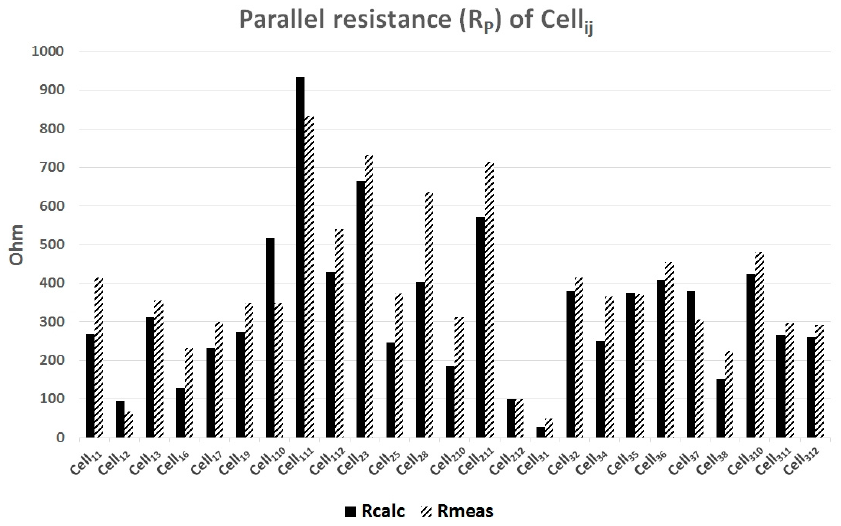
Figure 20. Manually measured resistances of some cells (Rmeas) vs. resistances calculated from the slopes in Figure 18 (Rcalc).